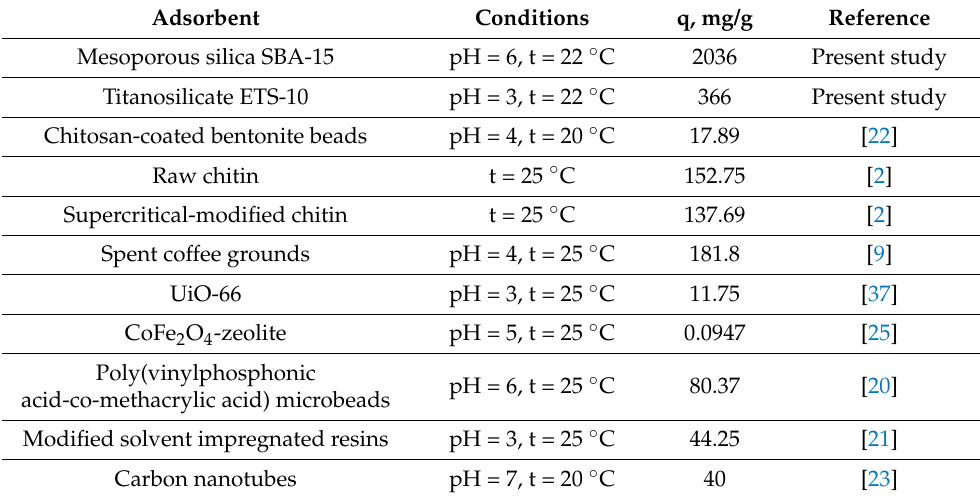
Table 2. The comparison of maximum sorption capacity of In(III) ions onto different